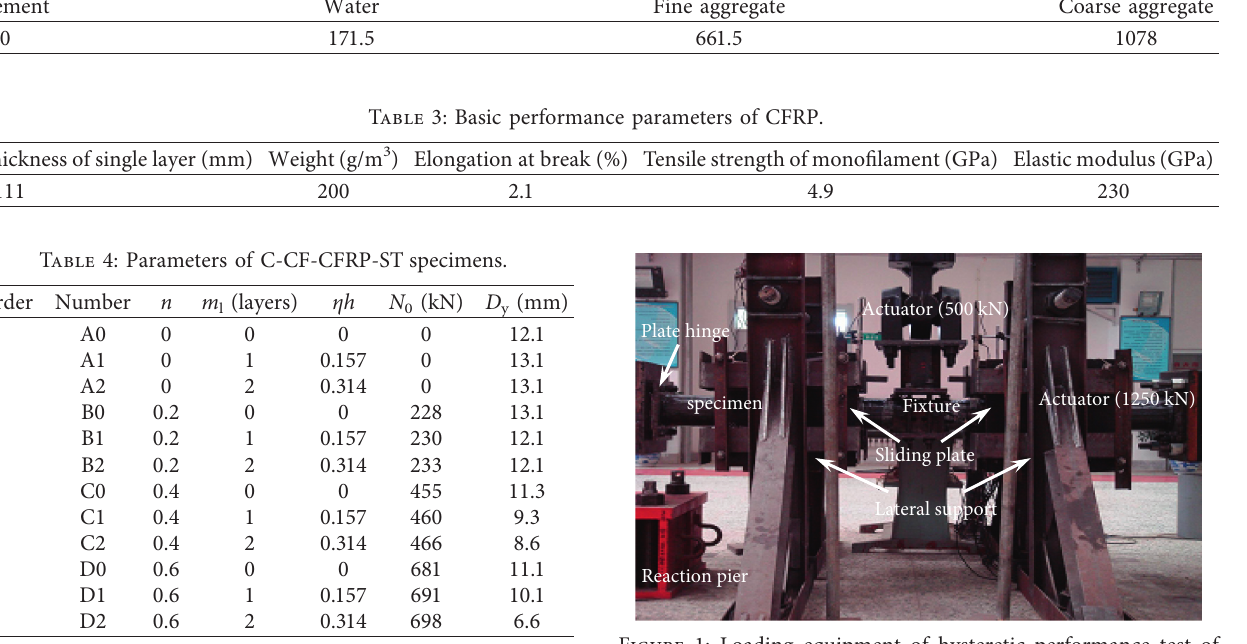
Figure 1: Loading equipment of hysteretic performance test of specimens.